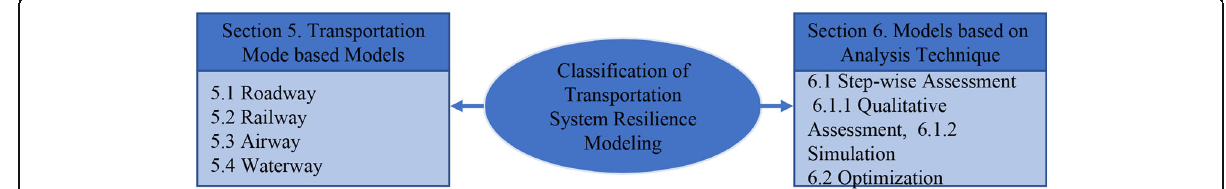
Fig. 1 Categorization of different sections and subsections of this review article on the transportation system